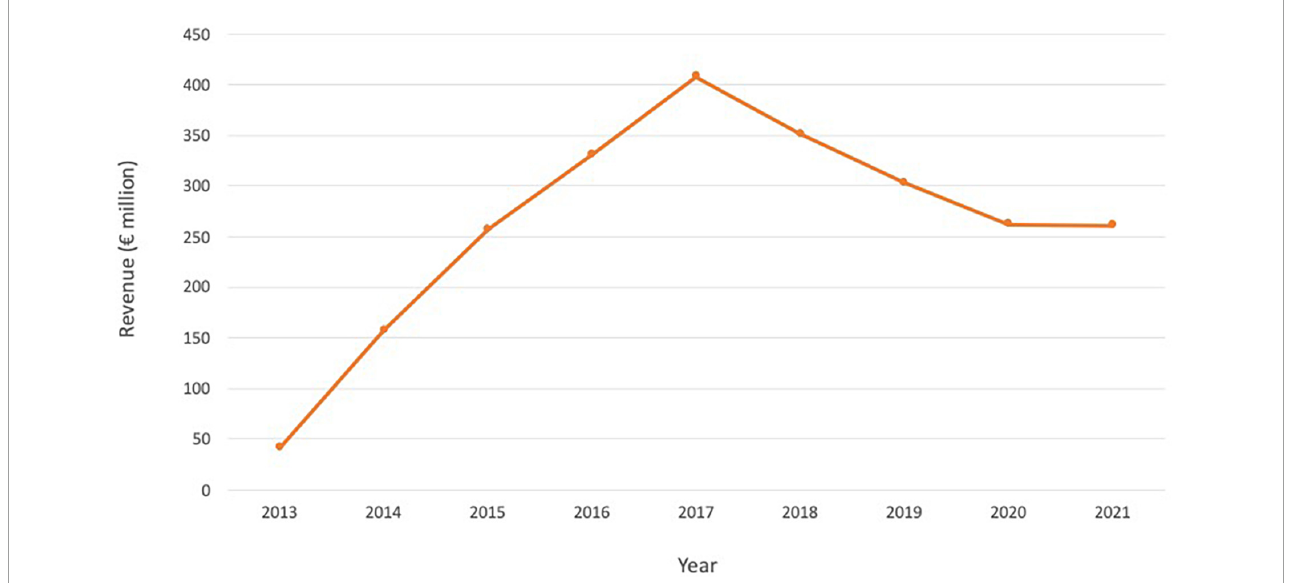
FIGURE3 Annual revenue for Xofigo over the period 2013–2021. Source: Bayer annual reports.